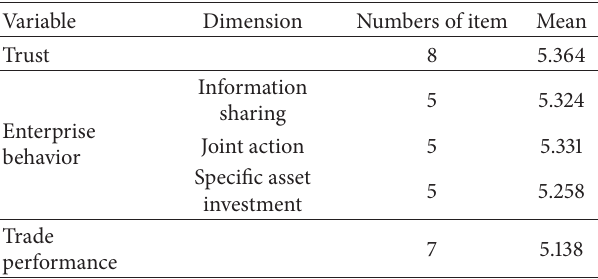
Figure 1: Hypotheses of the conceptual model. Table 8: The mean of each